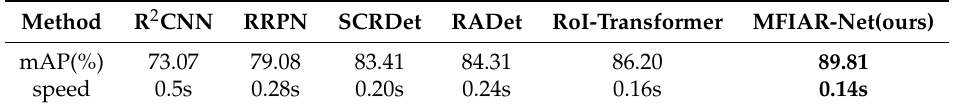
Table 2. Comparison of detection accuracy and speed with advanced methods on HRSC2016 test set. The numbers in boldface indicate the best detection